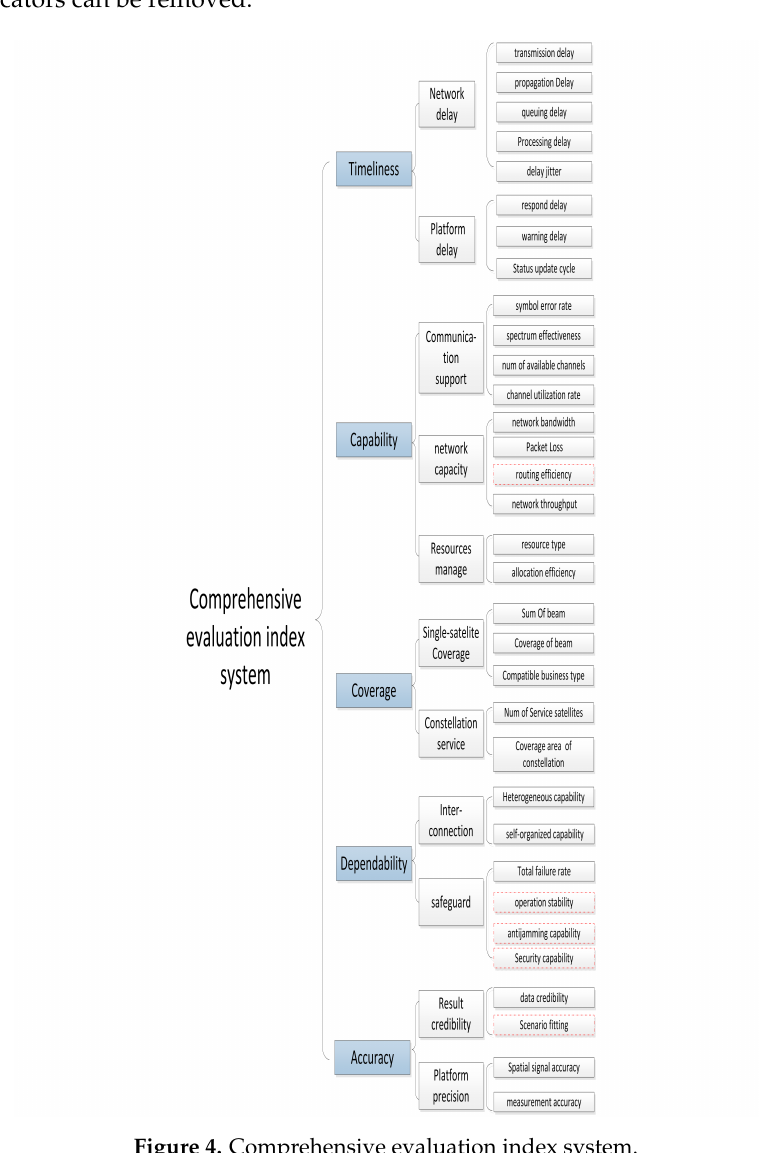
Figure 4. Comprehensive evaluation index